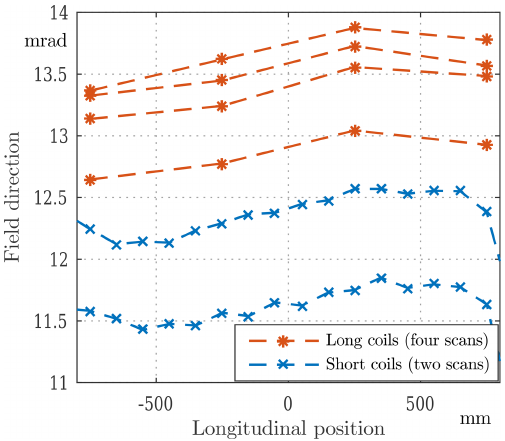
Figure 12. Field direction measurement results. First configuration with the level meter separated from the encoder.